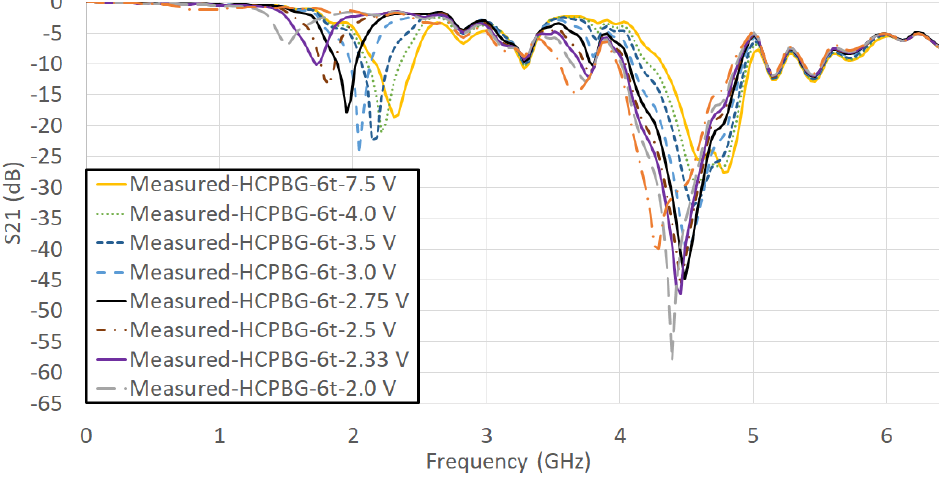
Figure 16. Measured—transmission loss for voltage values: 7.5, 4.0, 3.5, 3.0, 2.75, 2.5, 2.33, 2.0, 0.0 Volts. Table 6. Simulation—stop band center frequency and bandwidth